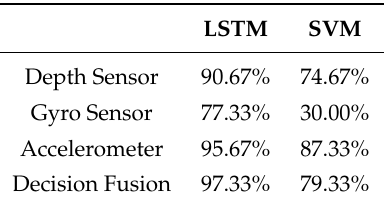
Figure 15. The confusion matrix of the SVM-based results: ( a ) depth sensor, ( b ) gyro sensor, ( c ) accelerometer, and ( d ) decision fusion results. Table 1. Comparison results of average